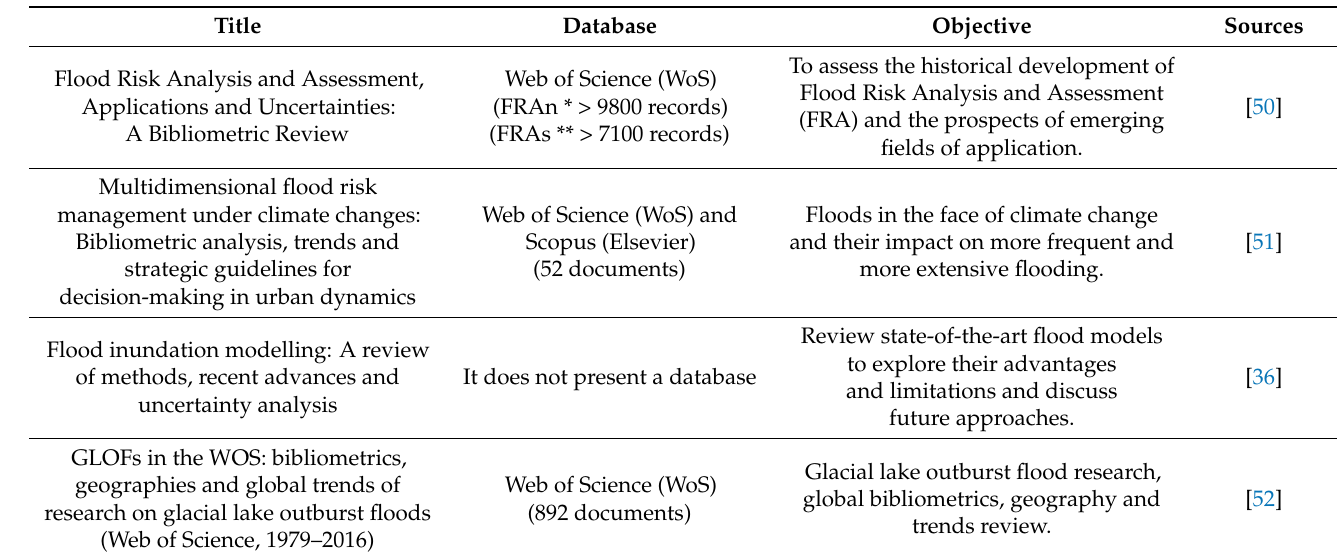
Table 2. Reviews and bibliometrics in the area of flood